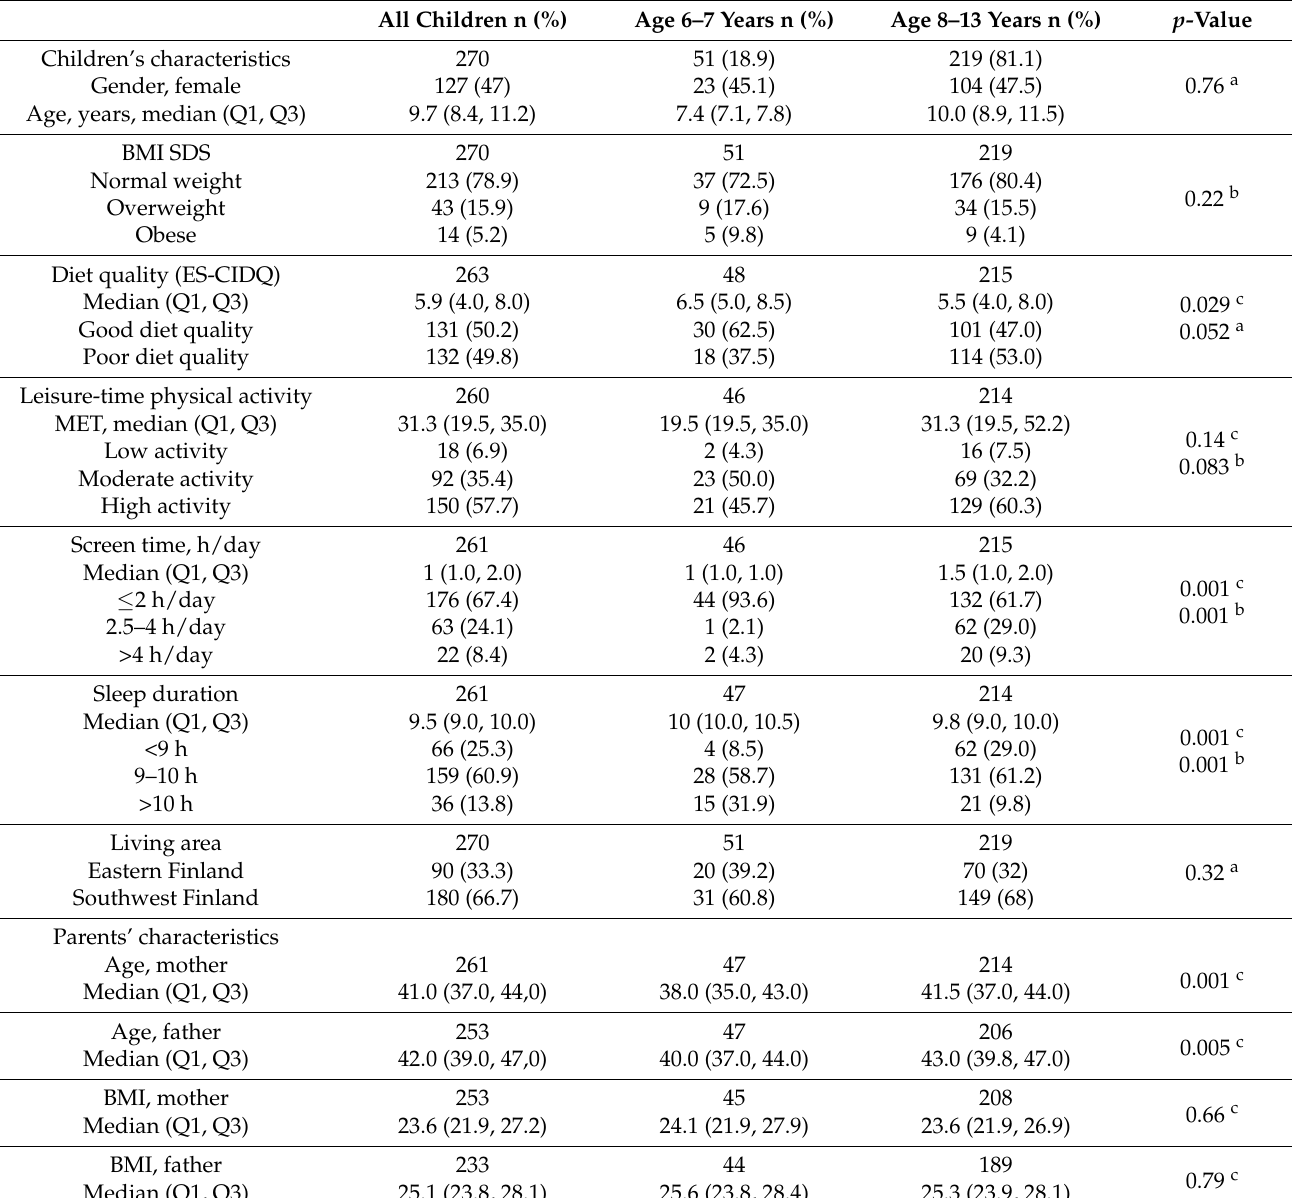
Table 1. Characteristics of children and their